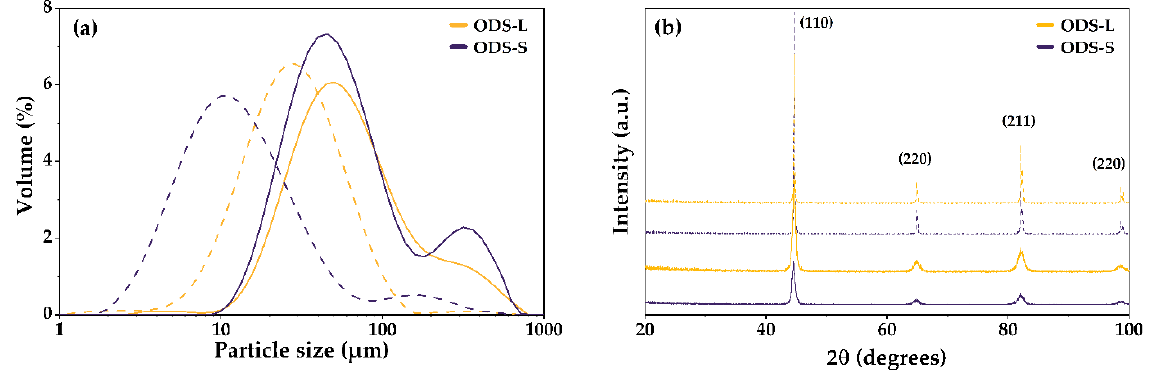
Figure 1. ( a ) Particle size distributions and ( b ) XRD patterns showing the evolution of the ODS-L and ODS-S steel powders with milling. The dashed lines correspond to the pre-alloyed powders, and the solid lines correspond to the mechanically alloyed powders.